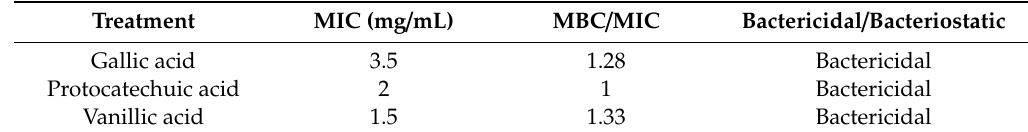
Table 1. Antibacterial effect of phenolic acids.